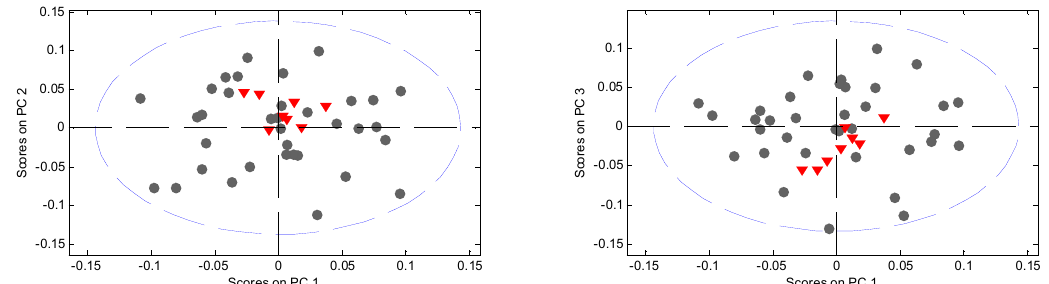
Figure 3. PCA score plots of Raman intensity matrix for petrolatum-(top) and eucerin-based (bottom) ointments; PC1/PC2 (left panel) and PC1/PC3 (right panel), circles–calibration samples, triangles–commercial products.